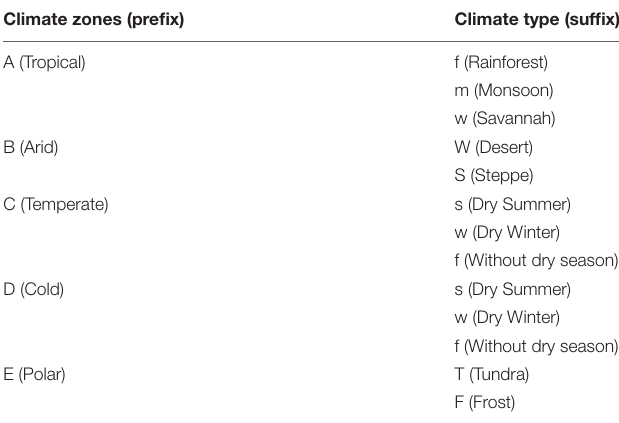
TABLE 3 | Codes defined in Köppen–Geiger climate classification and their meanings (Adapted from Peel et al., 2007). Climate zones